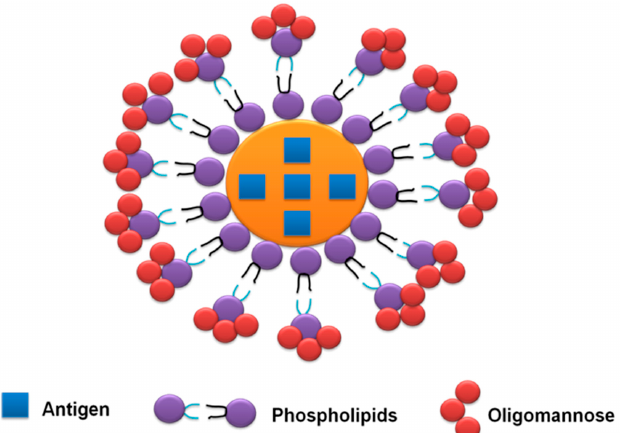
Figure 5. Representation of oligomannose-coated liposome adjuvant containing vaccine antigen.